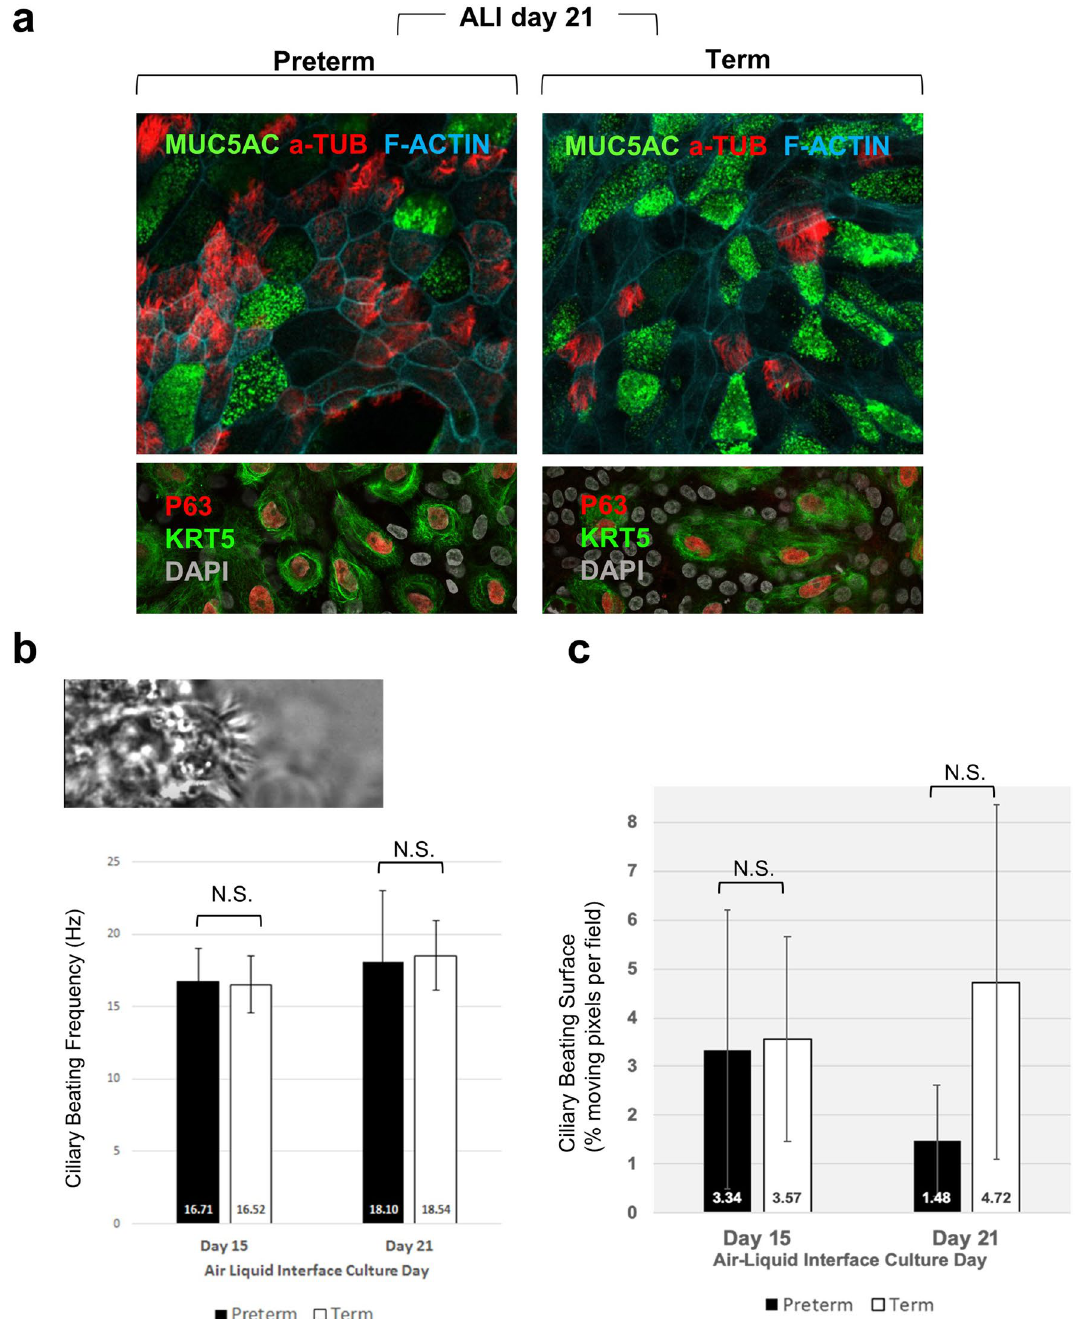
Figure 5. Prematurity does not prevent NP progenitor cell differentiation but compromises ciliary cell function. ( a ) Immunofluorescence of ALI day 21 organotypic cultures showing secretory (MUC5AC), multiciliated cells (acetylated a-tubulin) and basal cells (P63, KRT5) in both preterm and term epithelia (F-Actin and DAPI depicting cell boundaries and nuclei, respectively). ( b , c ) Functional analysis of cilia dynamics: representative picture in ( b ) of a multiciliated cell captured in the live image preparation for measurements of Ciliary Beat Frequency (CBF) and Ciliary Beating Surface (CBS) on ALI Day 15 and Day 21 organotypic cultures from preterm (n = 5) and term (n = 4). The average CBF is maintained at day 15 and day 21 in both preterm and term cultures. ( c ) The CBS is highly variable in both groups and the differences are non-significant (NS, Student t test). However, CBS in premature cultures tend to decline at a later stage when compared to term cultures. Graphs: bars are mean (± SED) of 10